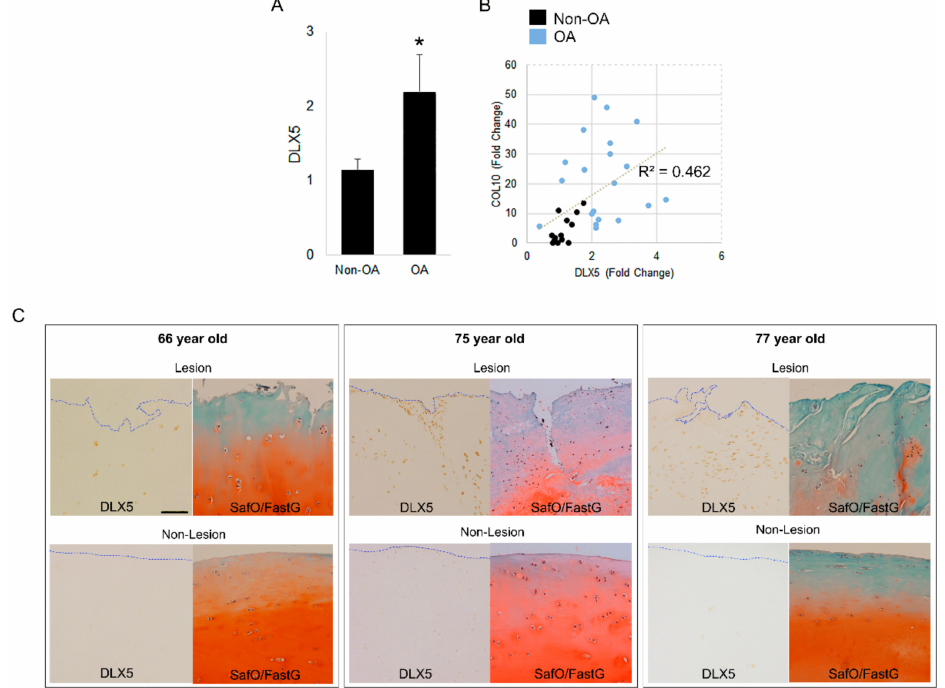
Figure 3. Distal-less homeobox 5 ( DLX5 ) is elevated in osteoarthritis (OA) chondrocytes and OA cartilage lesions. ( A ) RT-qPCR results of DLX5 and COL10 mRNA expression fold change in